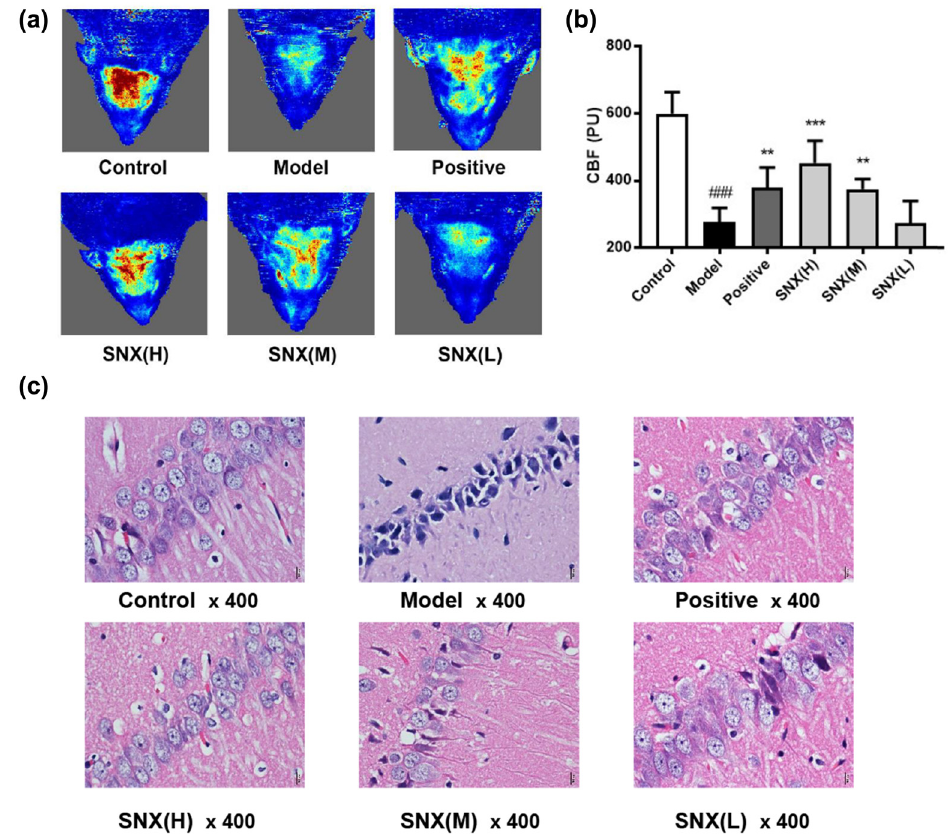
Figure 1: SNX - induced cerebrovascular dilation in CCH rats. ( a ) The e ff ect of SNX on CBF in CCH rats assessed using a Doppler blood fl ow imaging system. ( b ) Gray analysis of CBF images. ( c ) Images of hippocampal neurons of rats with HE staining ( 400 - fold ) ; ** P < 0.01, *** P < 0.001 versus the model group and ### P < 0.001 versus the control group ( n = 6 )